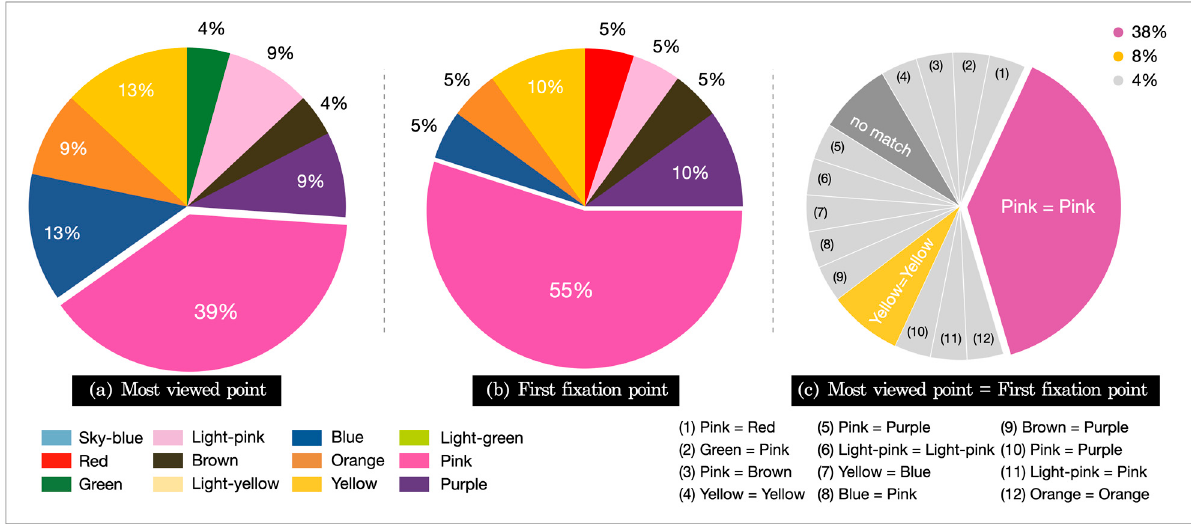
Figure 4. Gaze characteristics for the dental unit chair: ( a ) most viewed, ( b ) first fixation, ( c ) matched.